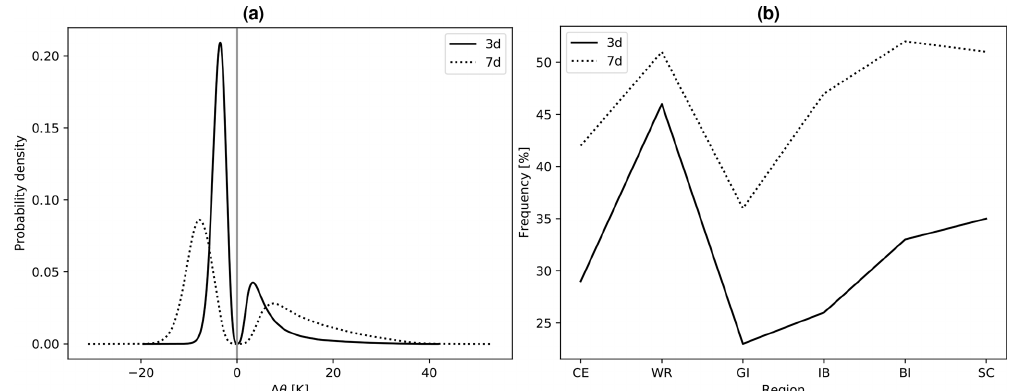
Figure 5. Diabatic processes in the heating and cooling branches 3 (solid line) and 7d (dashed line) before reaching upper-tropospheric anticyclones. (a) Probability density distribution of the potential temperature changes for air parcels reaching central European heat wave anticyclones. The grey line denotes the 0K border separating the heating and cooling branch. (b) Fraction of diabatically heated trajectories for all regions (CE: central Europe; WR: western Russia; GI: Greece–Italy; IB: Iberian Peninsula; BI: British Isles; SC: